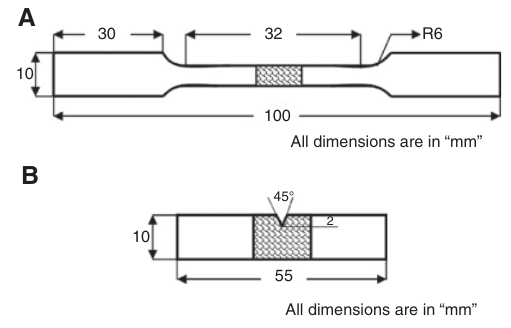
Figure 3: Dimensions of tensile and impact specimens. (A) Dimensions of the tensile specimen – Unnotch, (B) Dimensions of tensile and impact specimens. Figure 4: Engineering stress-strain